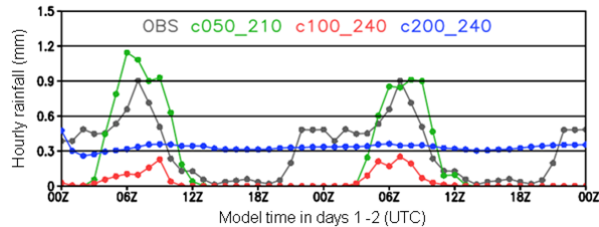
Figure 6. The time series of spatially averaged hourly rainfall (mm) over Taiwan in the observations (gray) and three model experi- ments: with uniform southwesterly winds at 5ms − 1 from 210 ◦ (green), at 10ms − 1 from 240 ◦ (red, i.e., the CTL), and at 20ms − 1 from 240 ◦ (blue). The observation is the mean diurnal cycle (re- peated twice) from the dates of the sounding data (27–29 May and 1, 4, and 11 June